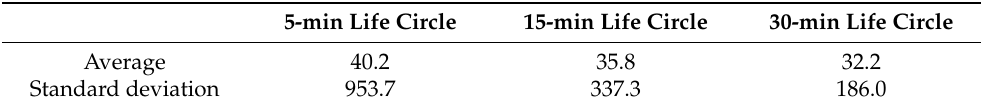
Table 5. Statistical results of accessibility for different traveling